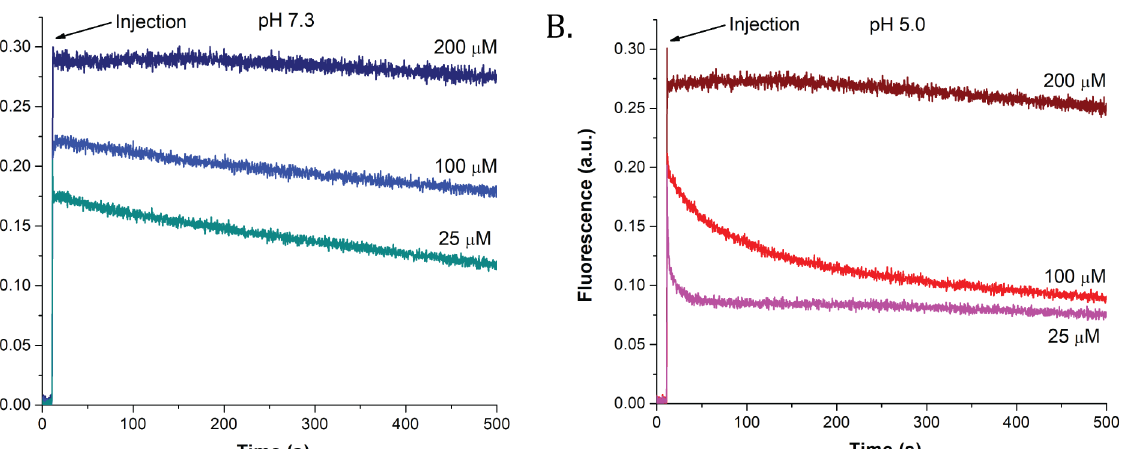
Figure 1. Fluorescence quenching analysis of LHCII trimers during bulk measurement in vitro. Panels ( A , B ) represent time course of fluorescence quenching of LHCII trimers (in HEPES 10 mM (pH 7.3) and 200 µM n-dodecyl- β -D-maltoside (DDM)) injected in a buffer of pH 7.3 ( A ) or 5.0 ( B ) at different detergent concentrations. ( C ) Titration curves of quenched fraction of fluorescence calculated from panels ( A , B ) (see the Section 4 for calculation). ( D ) Rate constants of fluorescence quenching, calculated by fitting time courses of fluorescence ( A , B ) with a sigmoidal Hill equation y = [axb]/[cb + xb] (see, for instance, [10,14] ). Circles/squares = data average; dashed lines = data fittings; error bars: SD. Data are average of three measurements. The proposed organization of the detergent around the LHCII single trimer above and below critical micellar concentration (CMC) is represented under the graphs. Table 1. Summary of the measured fluorescence fraction quenched (FQ) and calculated K D s in the samples measured in Figure 1. pH